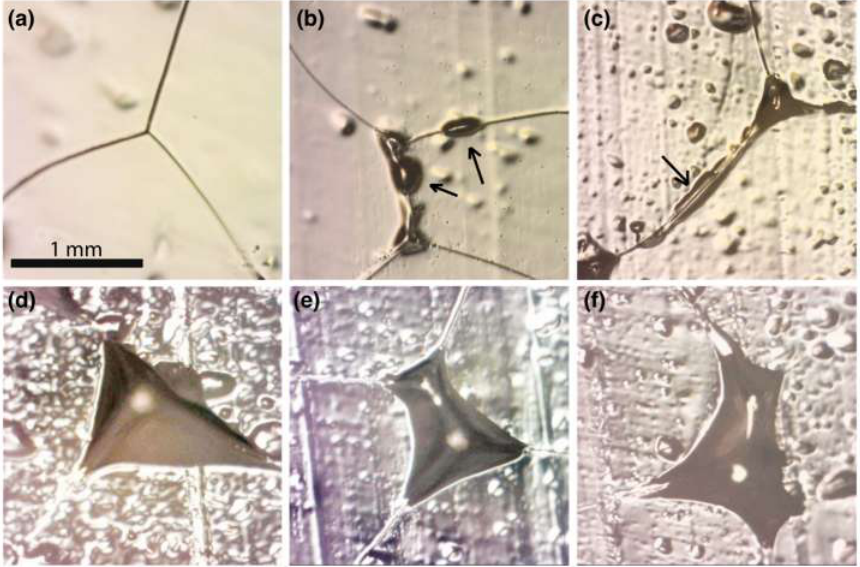
Figure 6. Representative micrograph images from ice–ammonia system at − 17 ◦ C, showing: ( a ) dry boundaries; ( b ) melt blebs between two grains; ( c ) melt between three grains, including a channel connecting the triple junctions; ( d ) melt between three grains (by far the most common morphology); ( e ) four grains; and ( f ) five grains.